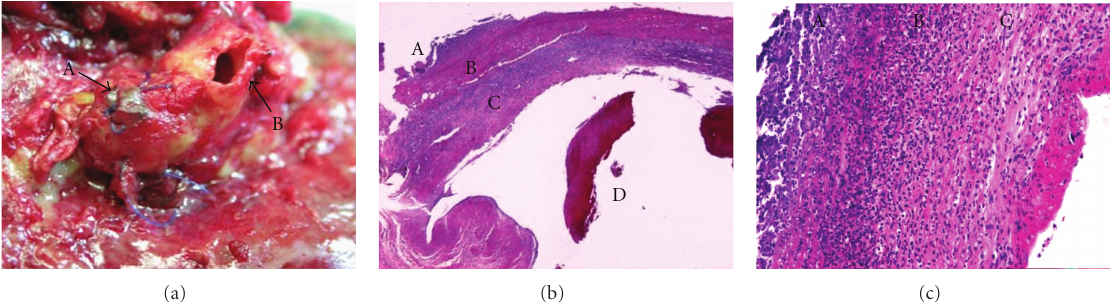
Figure 3: (a) The pulmonary artery was inflammated, edematous, and fragile. A: The first hemorrhage part in peripheral had been completely closed by prolene with pledgets. B: The second bleeding lesion was in the proximal lesion; a large cleft was opened. (b) A: adventitia; B: media; C: intima; D: organizing thrombi. Pathology disclosing the ruptured lesion of pulmonary arterial wall, in which adventitia and media tunicas were thin because of tearing o ff . (c) A: adventitia; B: media; C: intima. A severe inflammatory change has been observed in the three tunicas of the pulmonary arterial